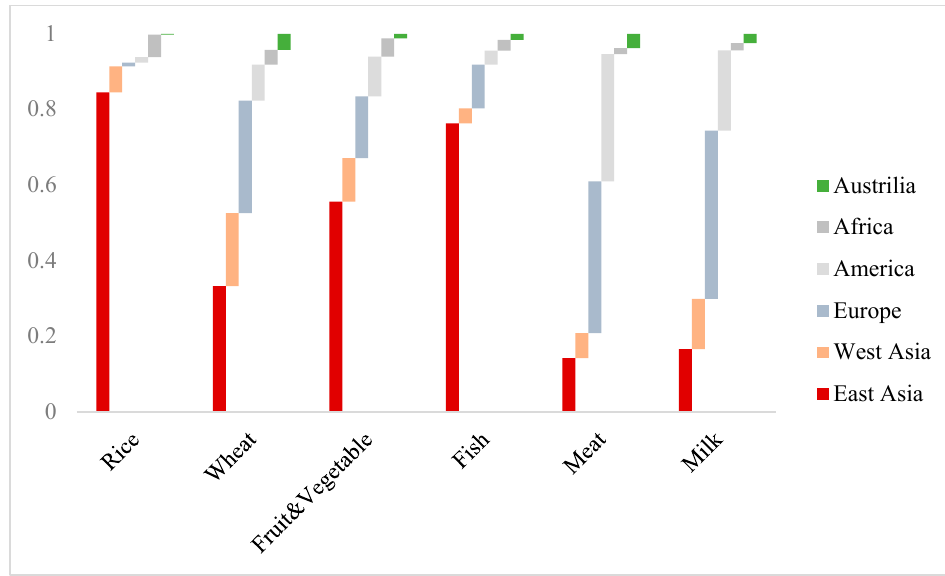
Figure 1. Percentage contribution of different regions to global aggregate supply in 2030.